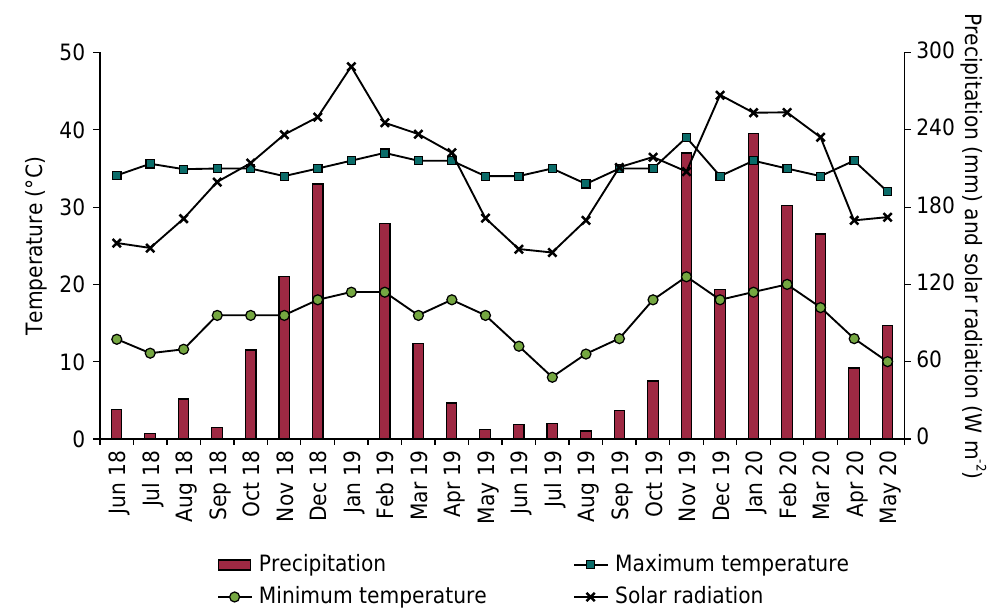
Figure 1. Values of climatic variables observed during the study period (June 2018 to May